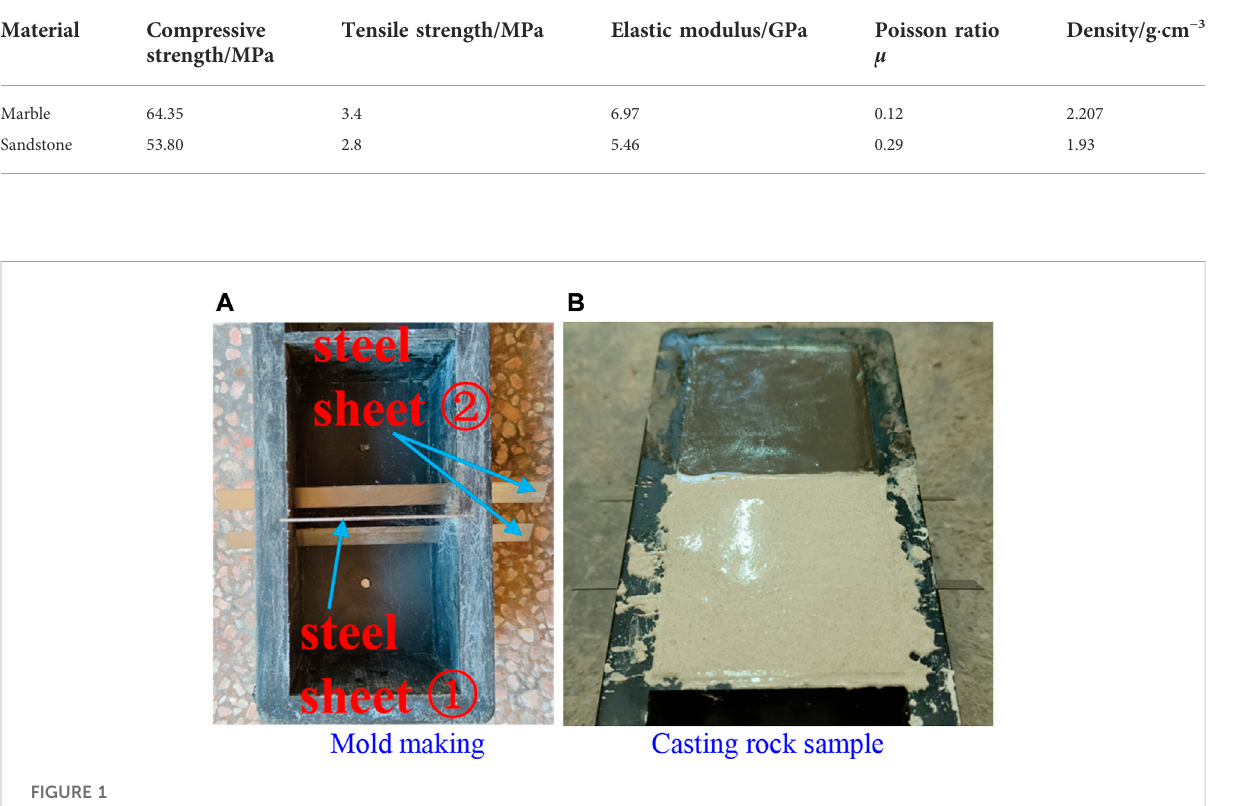
FIGURE 1 Process of preparing coplanar fracture composite rock sample. (A) Mold making, (B) Casting rock